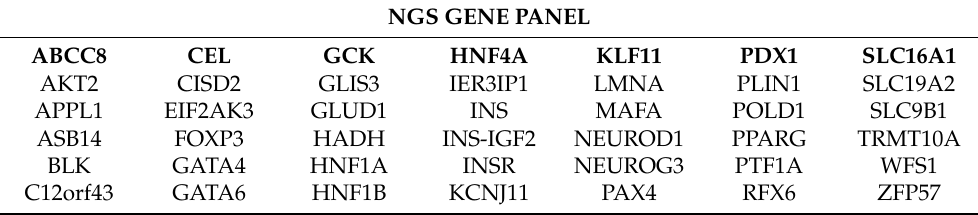
Table 1. Panel of genes associated with monogenic diabetes, analysed in the